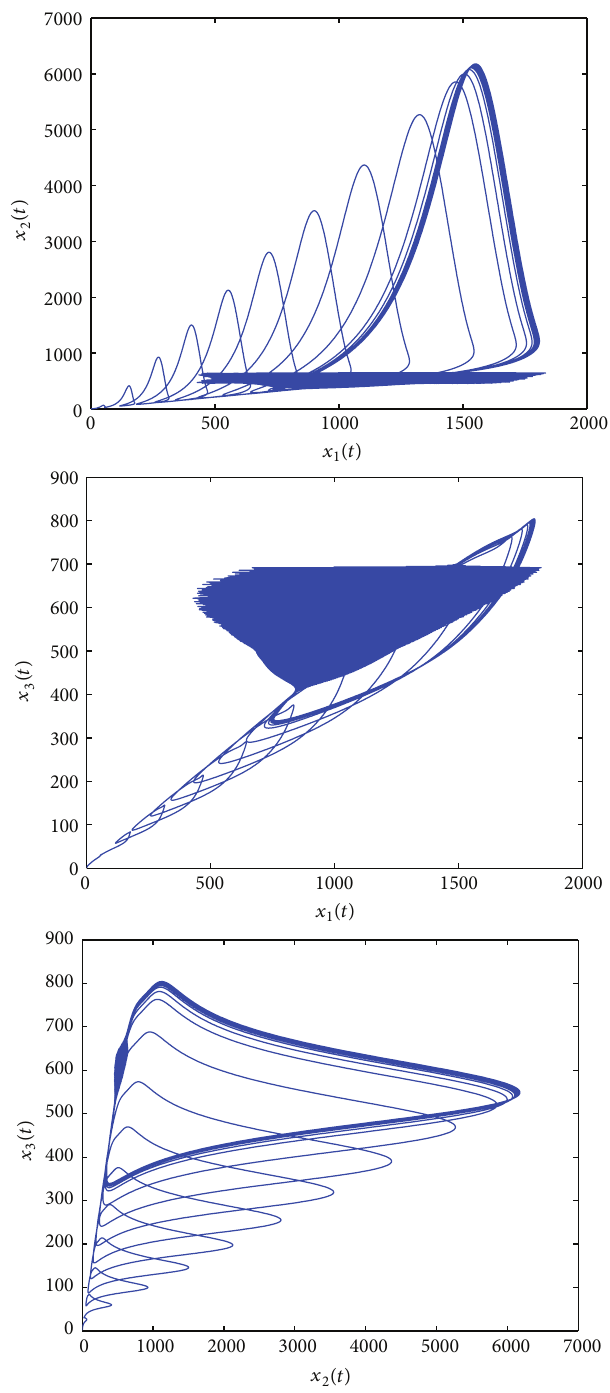
Figure 1: Numerical simulation for system (68). Here, we take the initial value 𝑥 0 = (𝑥 10 ,𝑥 20 , 𝑥 30 ) = (1, 1.5, 2)